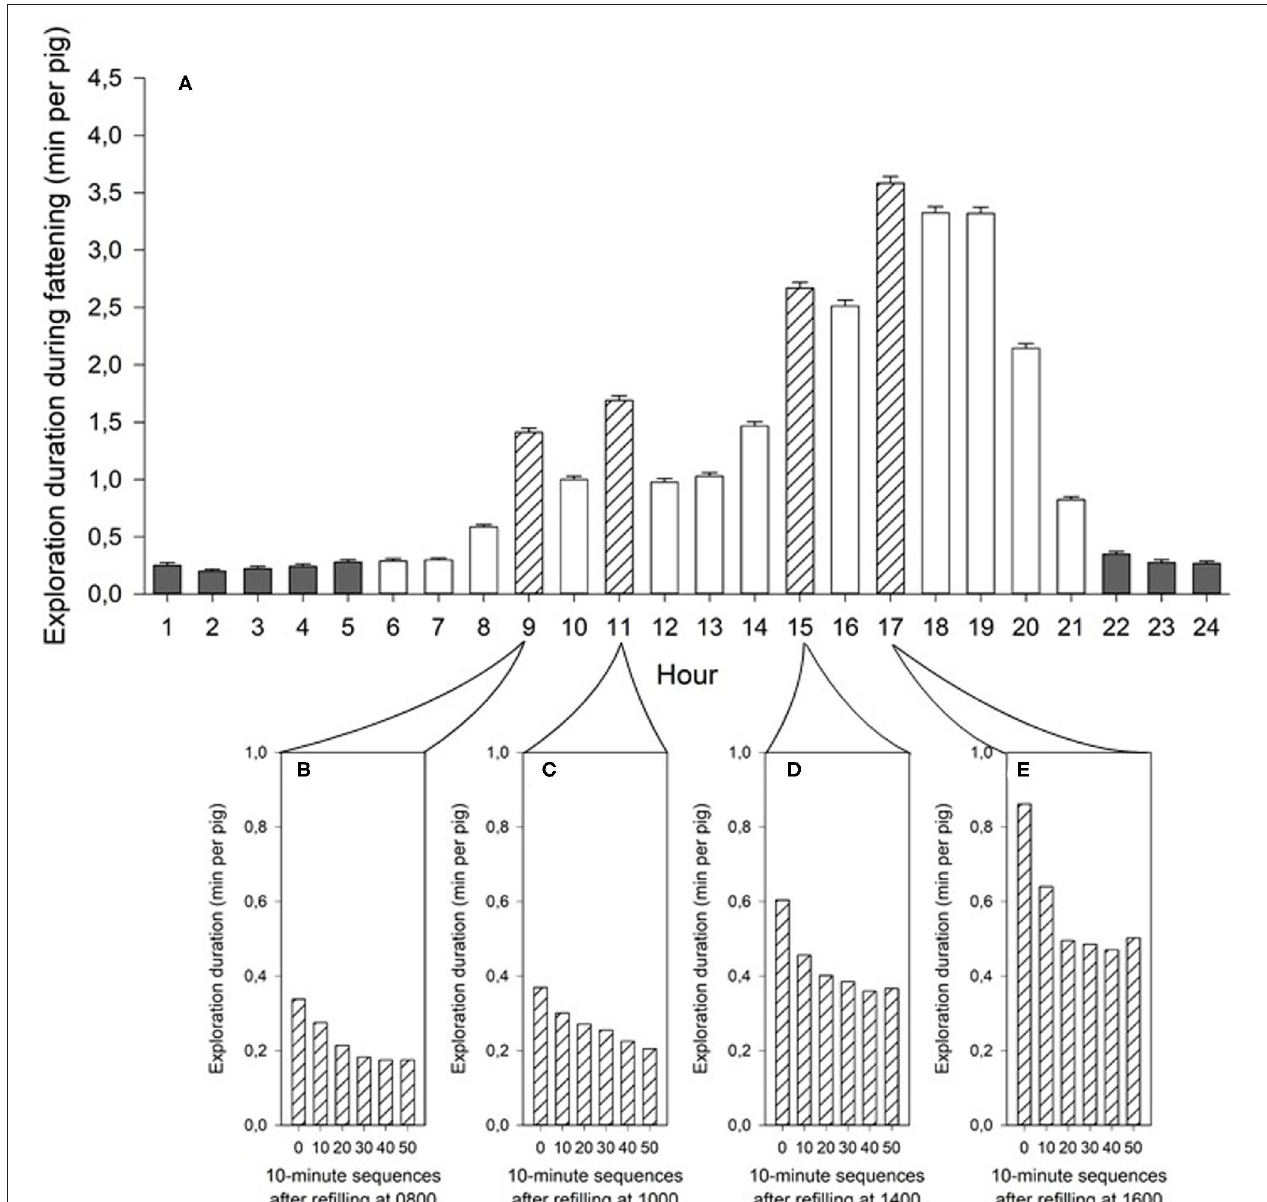
FIGURE 6 | (A) Diurnal pattern of exploration duration (mean ± SE minutes per pig) at the dispenser filled with chopped straw in treatment R4 (four additional offers of chopped straw at 0800, 1000, 1400, and 1600) during fattening. (B–E) Exploration durations in 10-min sequences within the hour after refilling the rooting area (striped bars). Light bars indicate light phase and dark bars indicate dark